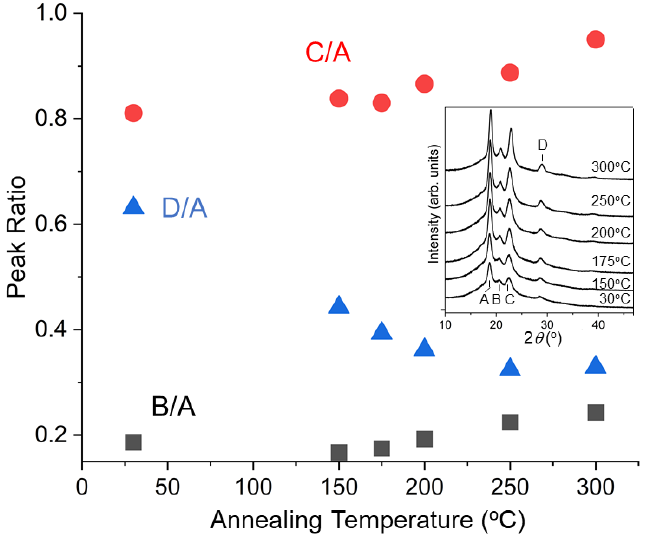
Figure 2. Area ratios of WAXRD peaks B (2 θ = 20.7 °), C (22.8 °), D (28.8 °) to peak A (18.9 °) calculated after removing the broad background coming from the amorphous portion. The inset shows the raw WAXRD spectra.